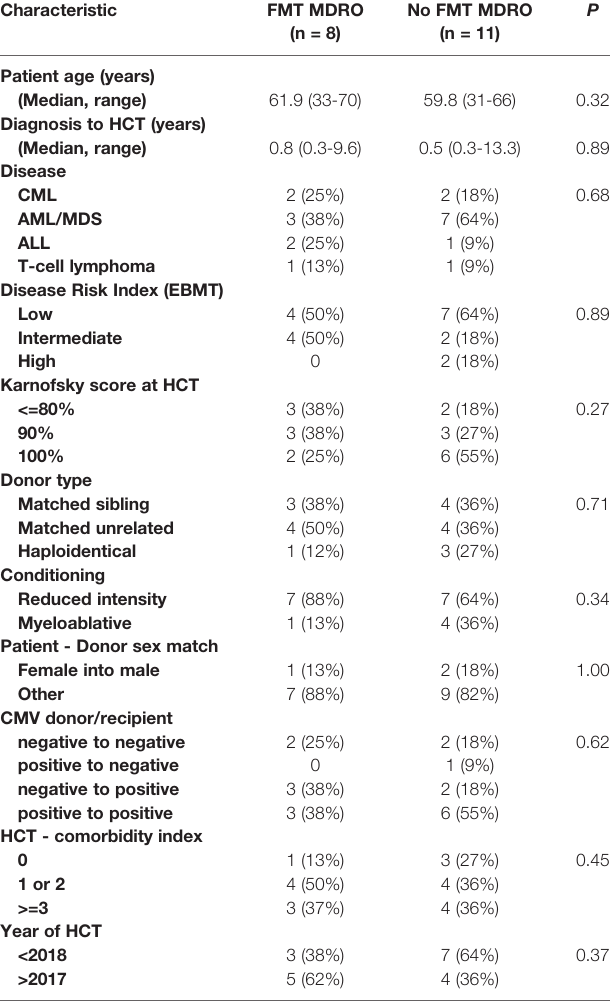
TABLE 1 | Demographics and further clinical details of MDRO-colonized HCT